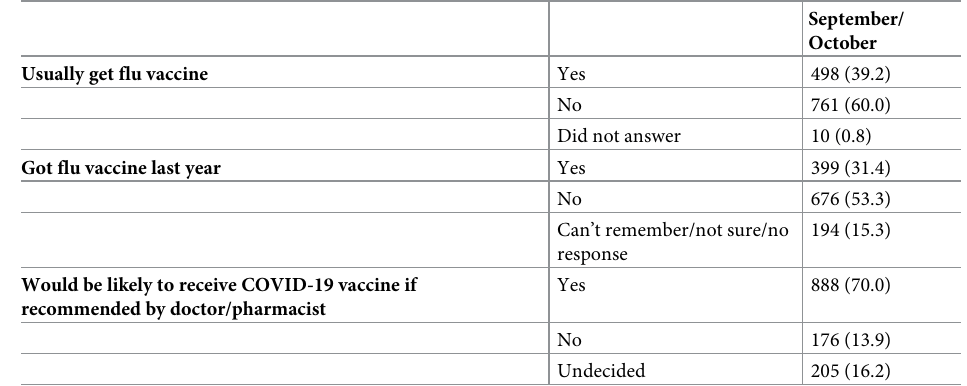
Table 3. Seasonal flu vaccine uptake and doctor/pharmacist recommendation.